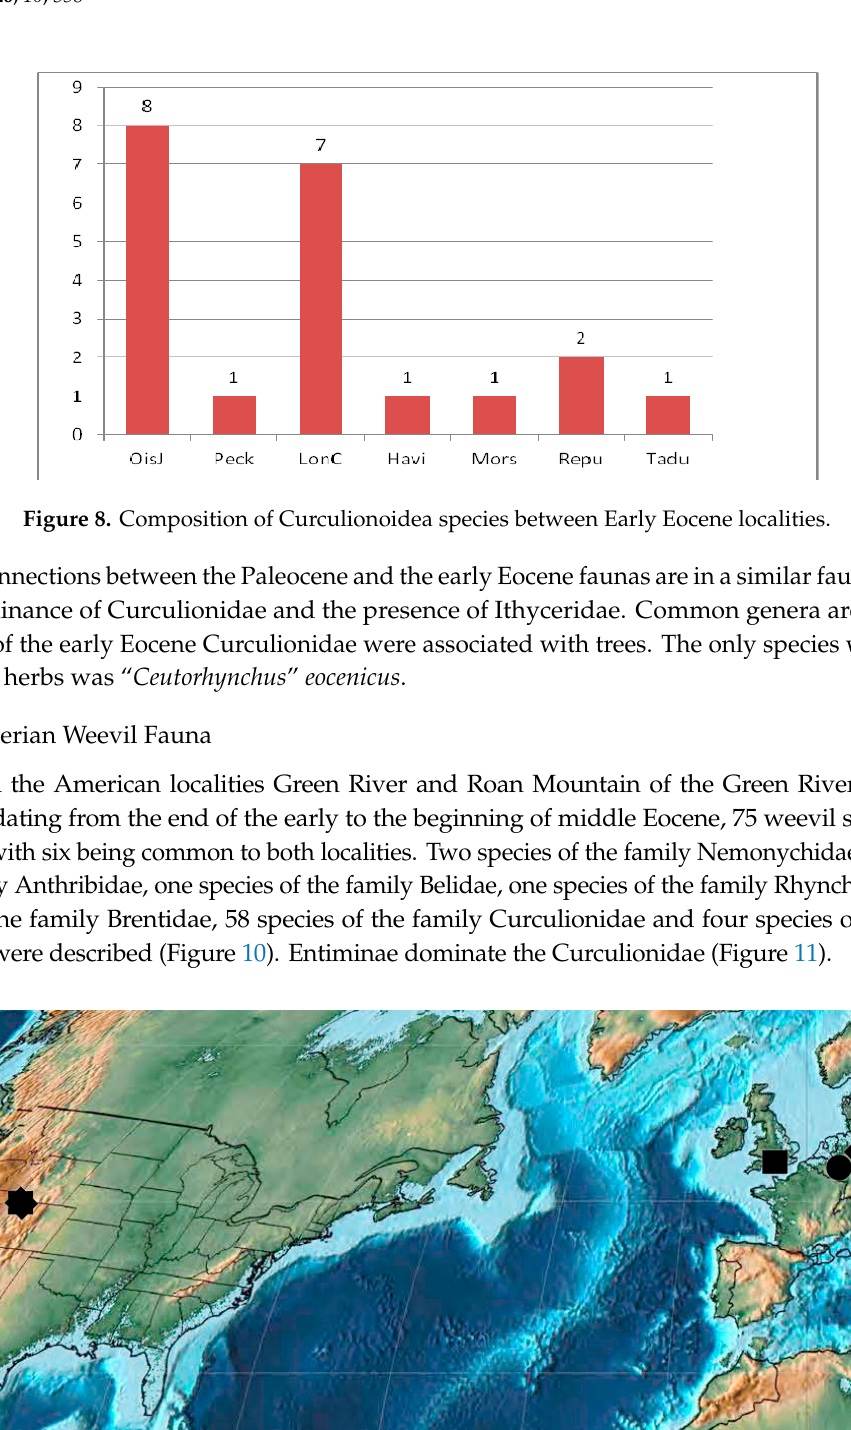
Figure 7. Composition of species of Curculionoidea in the Early Eocene fauna.